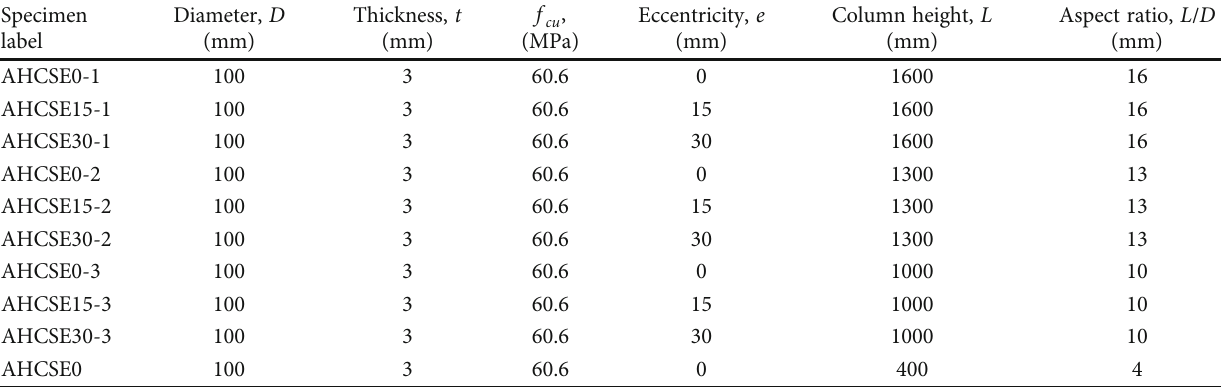
Table 1: Basic parameter table of specimen.